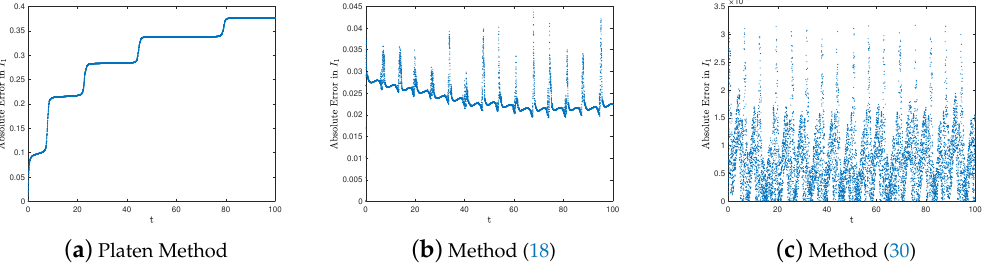
Figure 9. Numerical sample paths of the Platen method, method (18), and method (30).